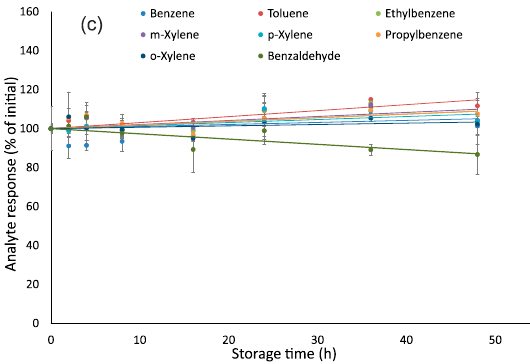
ff ect of storage time on responses of analytes: ( a )—2,2,4-trimethylpentane, Figure 2. Effect of storage time on responses of analytes: ( a )—2,2,4-trimethylpentane, chlorobenzene, Figure 2. E